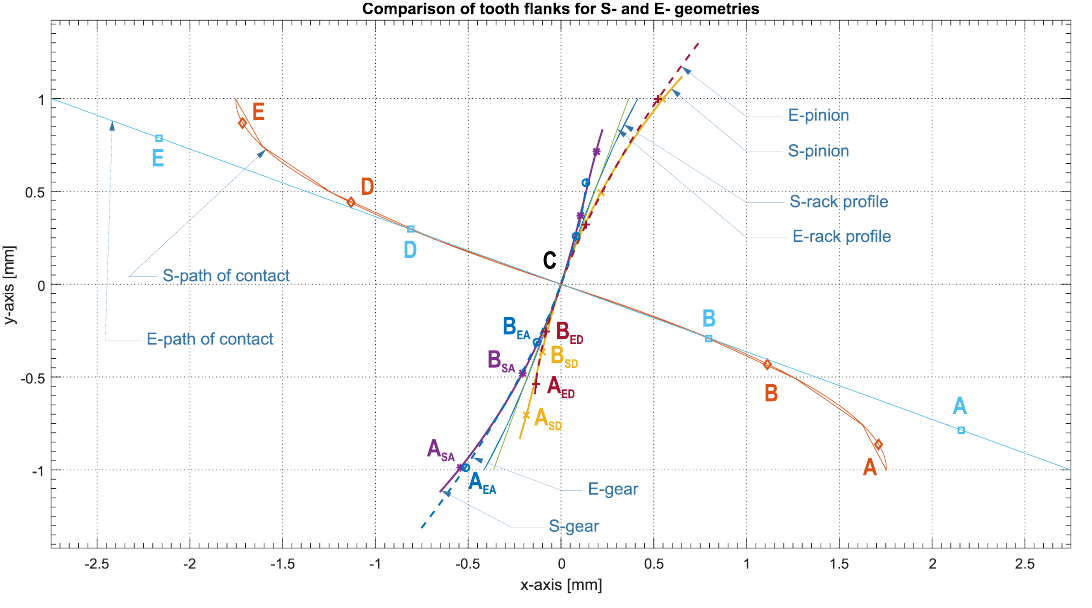
Figure 1. Comparison between the meshing of S- and E-gears.